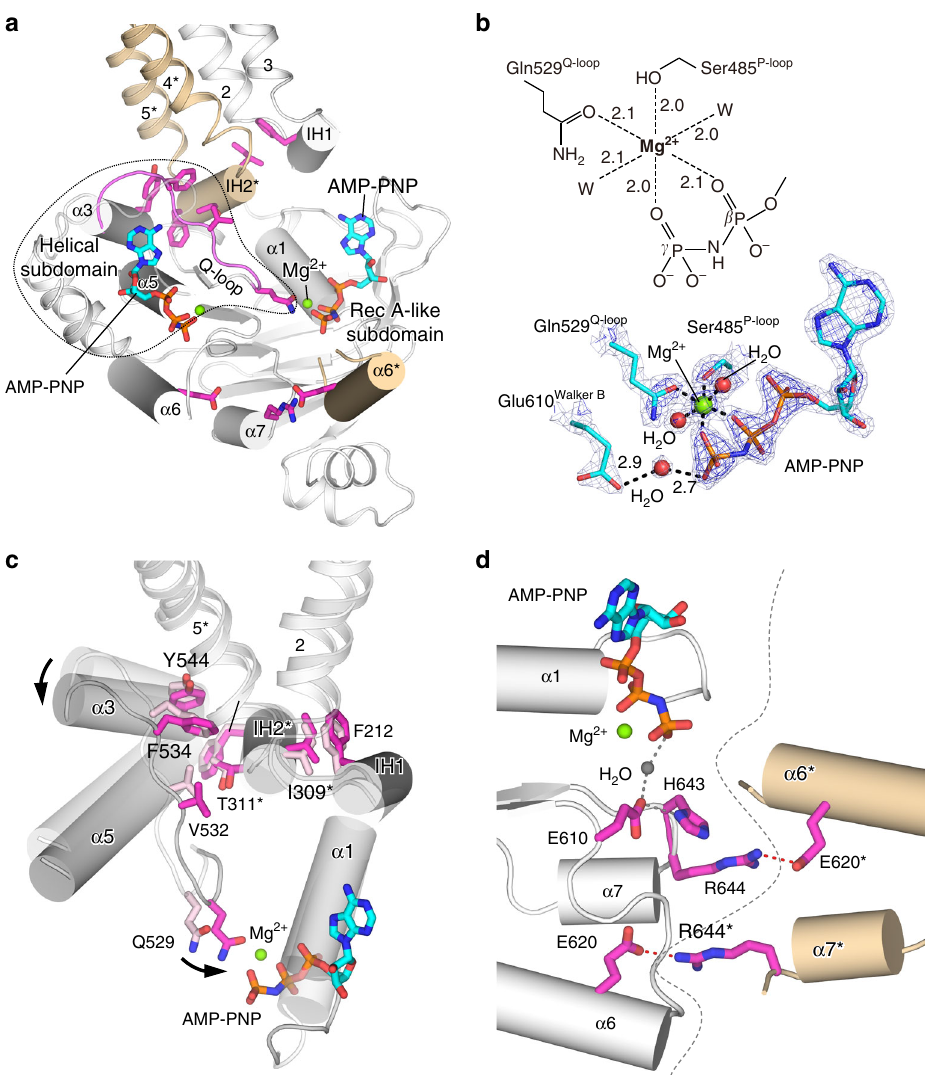
Fig. 5 Coupling between NBD − TMD and NBD − NBD* in the outward-facing conformation of QTA CmABCB1. a NBD bound to Mg 2 + (cid:129) AMP-PNP in a subunit of QTA CmABCB1, viewed parallel to the membrane. The NBD and TM2 − IH1 − TM3 of one subunit are shown in white, except for Q-loop- α 3, shown in magenta; TM4* − IH2* − TM5* and α 6* of the other subunit are shown in orange. The key residues for coupling between NBD − TMD and NBD − NBD* are shown as magenta sticks. b Octahedral coordination of Mg 2 + . Light blue and blue meshes represent the 2 F o − F c map contoured at 2.7 and 4.5 sigma, respectively. Polar interactions are shown as dashed lines. c Superposition of the NBDs in the outward- (gray) and inward-facing (white) conformations, based on the RecA-like subdomain. The direction of movement of α 3 and Gln529 between the inward- and outward-facing conformations are shown as arrows. Residues contributing to the coupling of movement between the NBD and TMD are shown as sticks. d Interaction between NBDs stabilized by RE-latch. The salt bridges in RE-latch are shown as red dashed lines, and the boundary between the two NBDs is shown as gray dashed